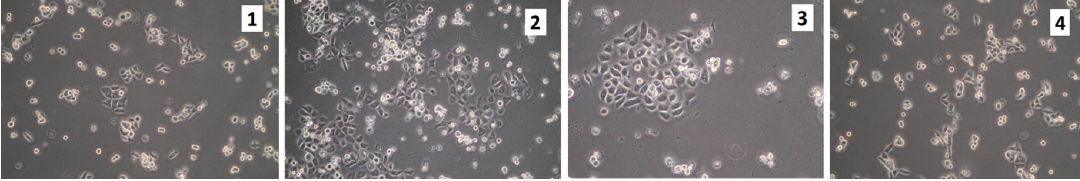
Figure 15. VK2/E6E7 cells on the edges of the scaffolds (sample 1—chitosan crosslinked with adipic and malonic acid; sample 2—chitosan crosslinked with adipic and L -glutamic acid; sample 3—chitosan crosslinked with adipic, L -glutamic and malonic acid; sample 4—chitosan crosslinked with adipic and levulinic).